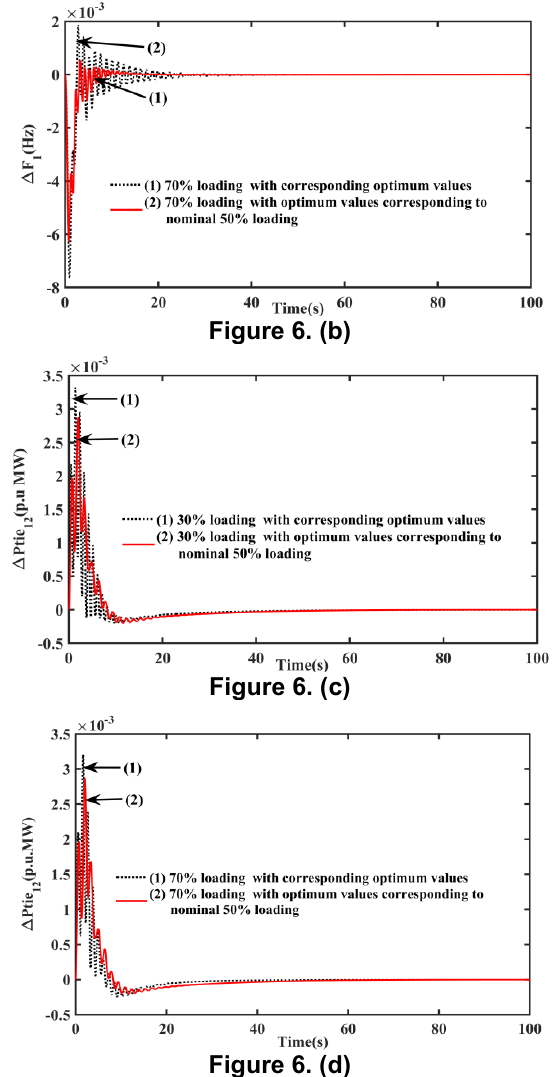
Figure 6. Dynamic response comparison of the system at varied with nominal condition vs. time (a) Frequency deviation in area-1 at 30% loading condition, (b) Frequency deviation in area-1 at 70% loading condition, (c) Tie-power deviation among area-1 and area-2 at 30% loading condition and (d) Tie-power deviation among area-1 and area-2 at 70% loading